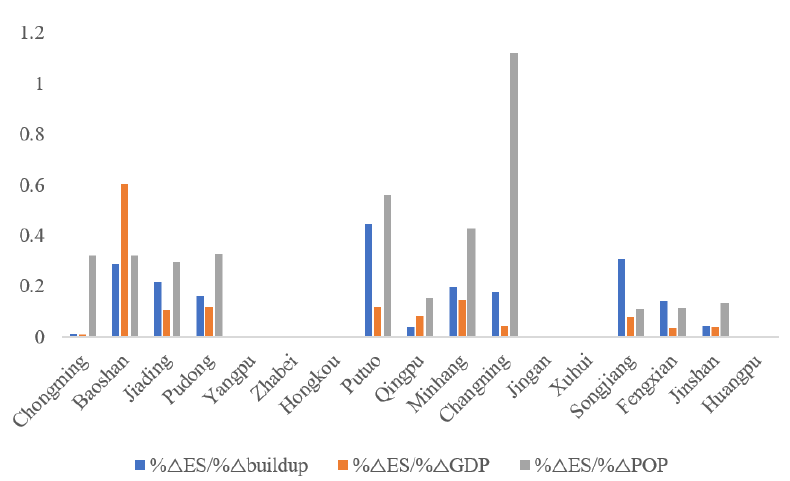
Figure 17. Values of urbanization elasticity of ESs at the district-level.